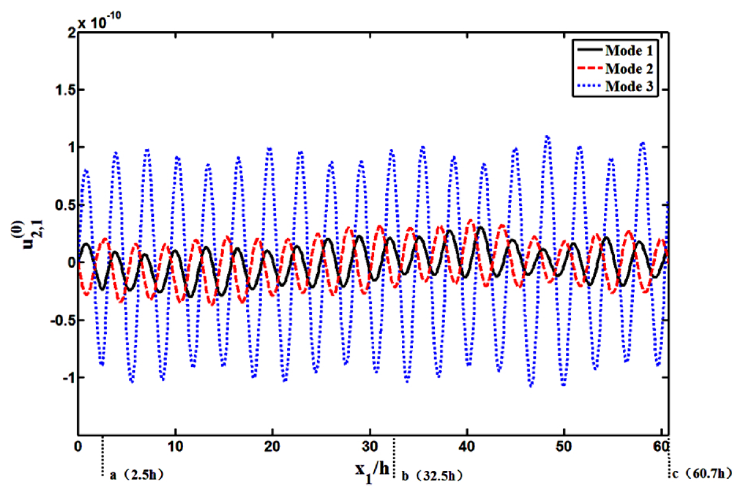
Figure 4. Thickness-shear (TSh) strain distribution ( u